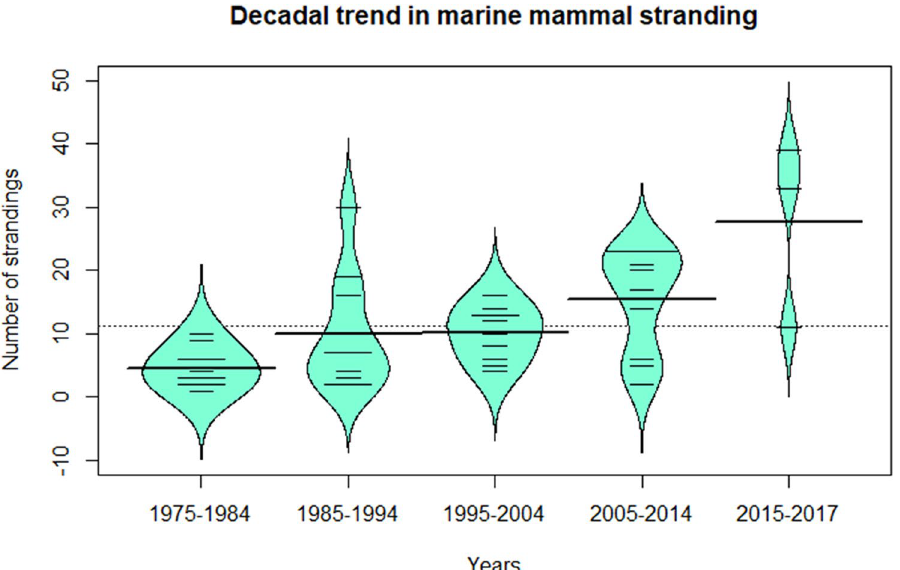
Figure 4. A beanplot of decadal trends in marine mammal stranding in India from data compiled between years 1975–2017. Data prior to 1975 was discontinuous over the years to be considered for decadal trends. The data for last decade considered here includes only two years (2015–17) where increased reporting is evident. The bold horizontal lines indicate the mean number of strandings in each decade whereas the smaller horizontal lines indicate stranding numbers recorded for each year within the